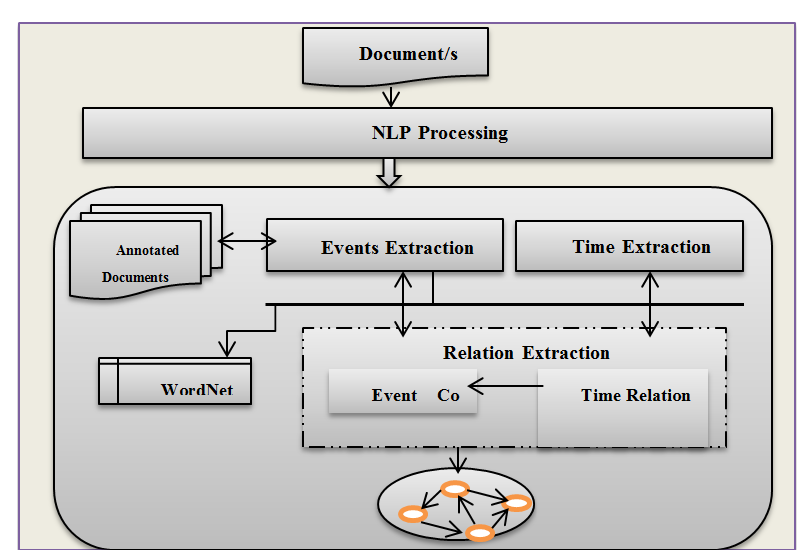
Fig. 1. Workflow of the Proposed